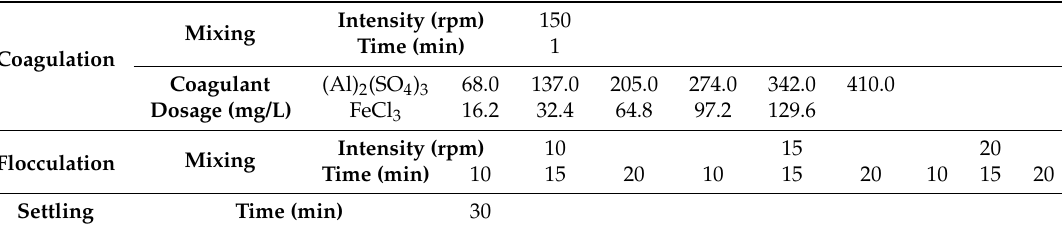
Table 1. Jar tests